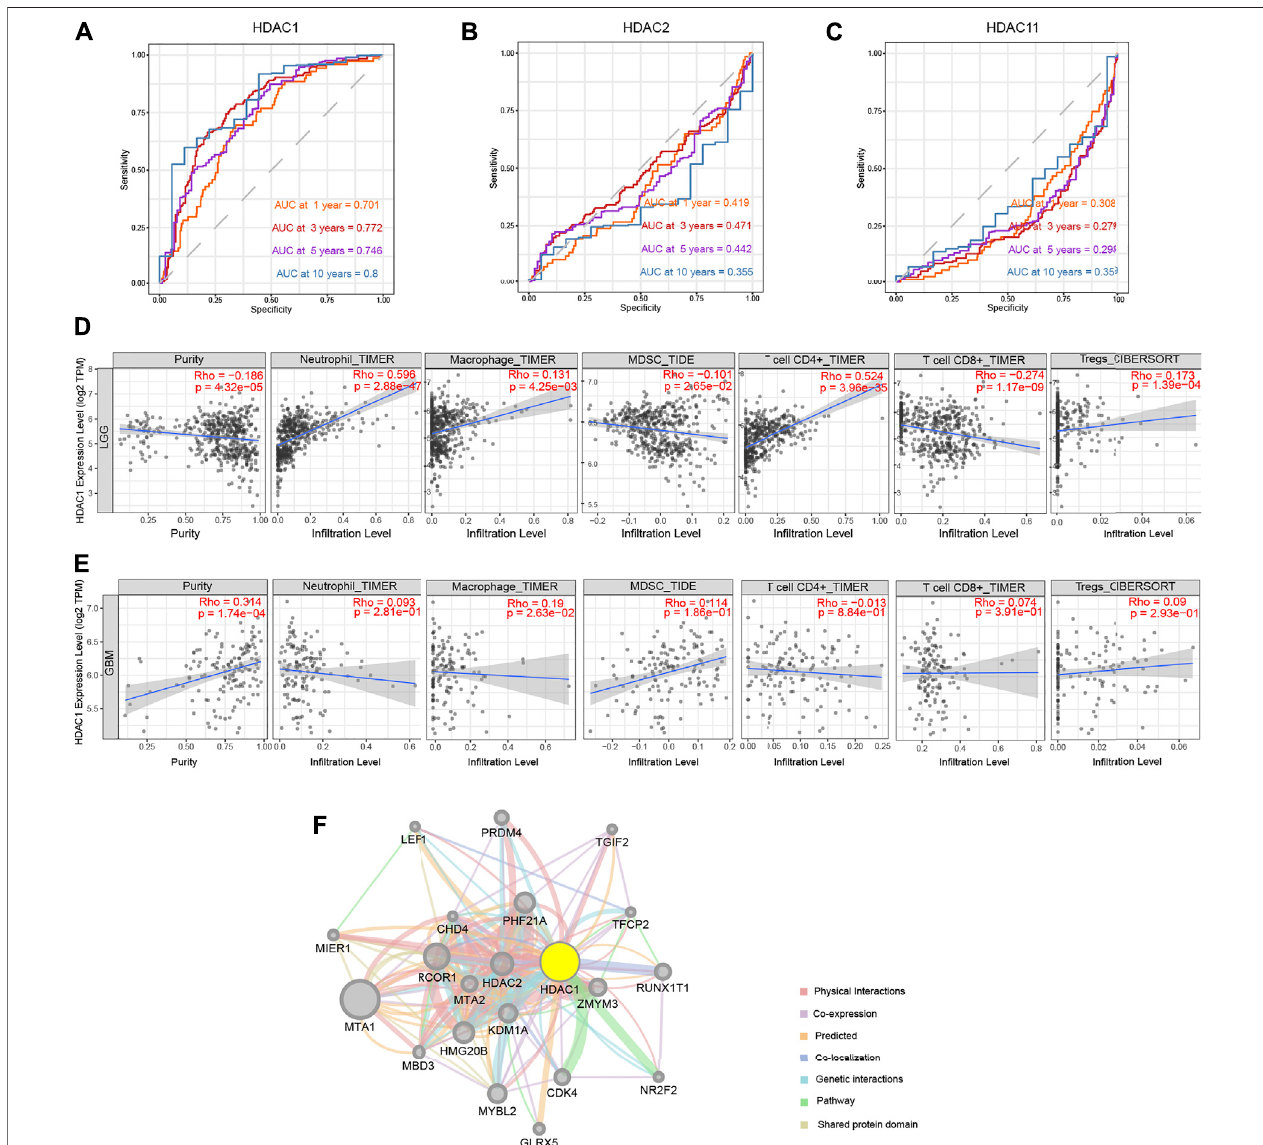
FIGURE 9 | Correlation between prognostic gene HDAC1 and immune in fi ltration, and related proteins. (A – C) Time-dependent ROC curve on HDAC1 , HDAC2 , and HDAC11 checkingforOSpredictionaccuracyat1-,3-,5-,and10-yearstimepoints. (D , E) Correlationbetween HDAC1 andneutrophil,macrophage,MDSC,CD4 + T cell, CD8 + T cell, and Treg in fi ltration in LGG and GBM. (F) Identi fi cation of HDAC1 -related gene network by